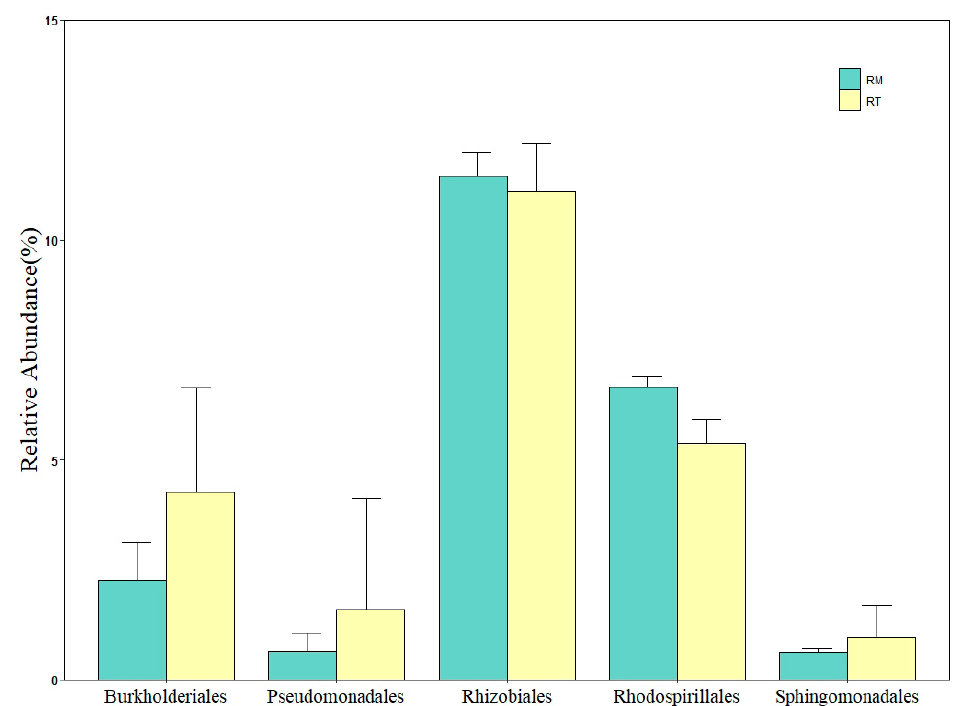
Figure 4. The relative abundance of bacterial class groups. Values are mean ± SE; residue retention—RT; residue removal—RM.